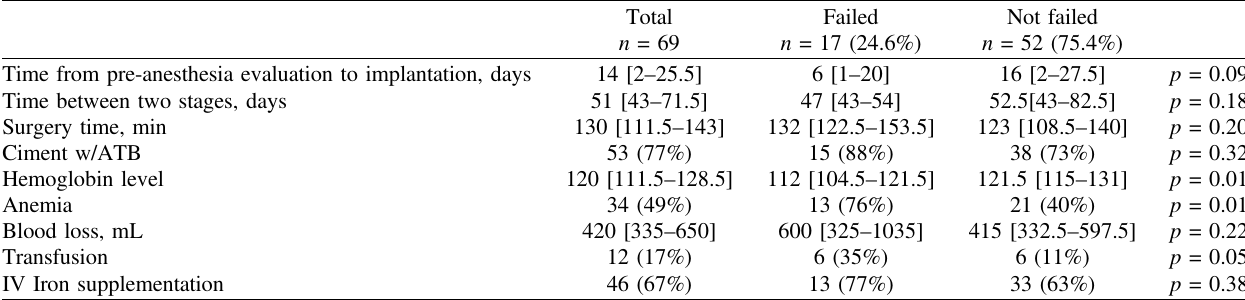
Table 5. Reimplantation surgery